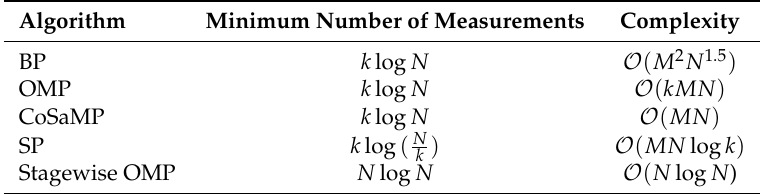
Table 2. Complexity and minimum measurements required for CS